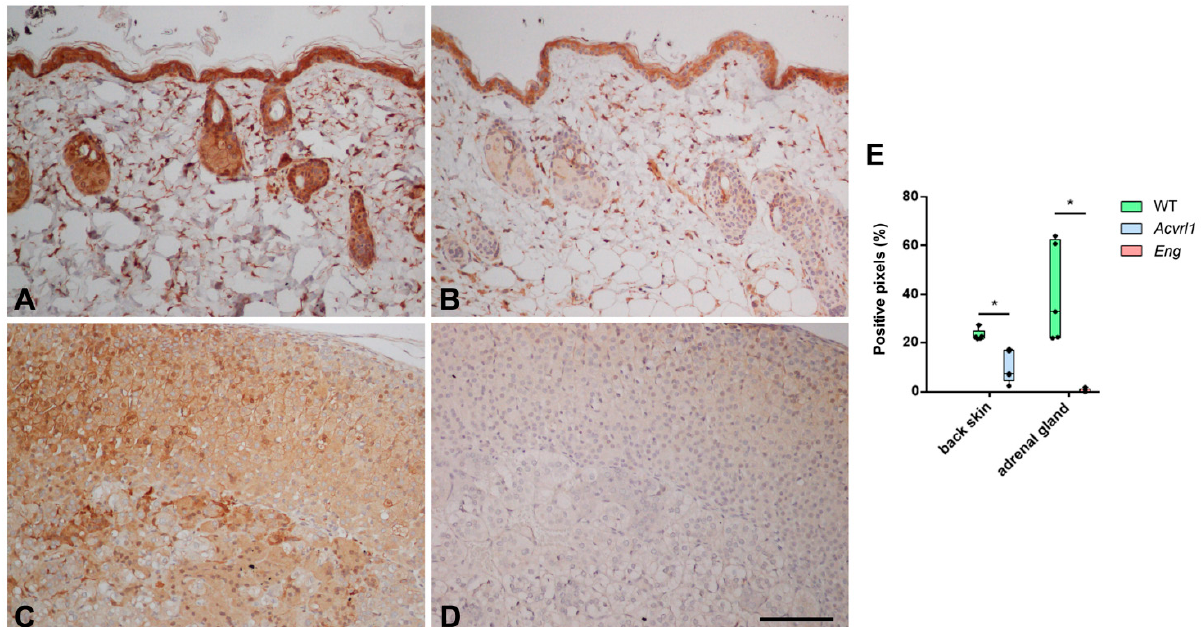
Figure 7. Representative photographs of the dorsal skin ( A , B ) and adrenal glands ( C , D ) of WT animals ( A , C ), and mutants for Acvrl1 ( B ) and Eng ( D ) stained with the anti-AM antibody. ( E ) Quantification of the immunohistochemical signal. Box plots represent the interquartile range with the median as a horizontal line. Whiskers encompass the maximum and minimum values of the population. Dots represent individual animals. *: p < 0.05. Scale bar for ( A – D ) = 100 µ m.